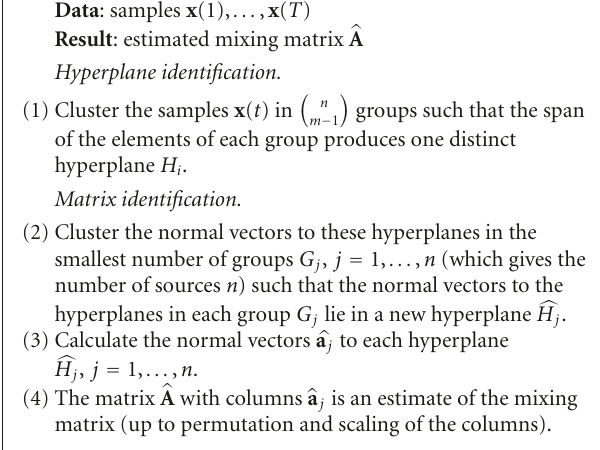
Algorithm 1: SCA matrix identification algorithm.